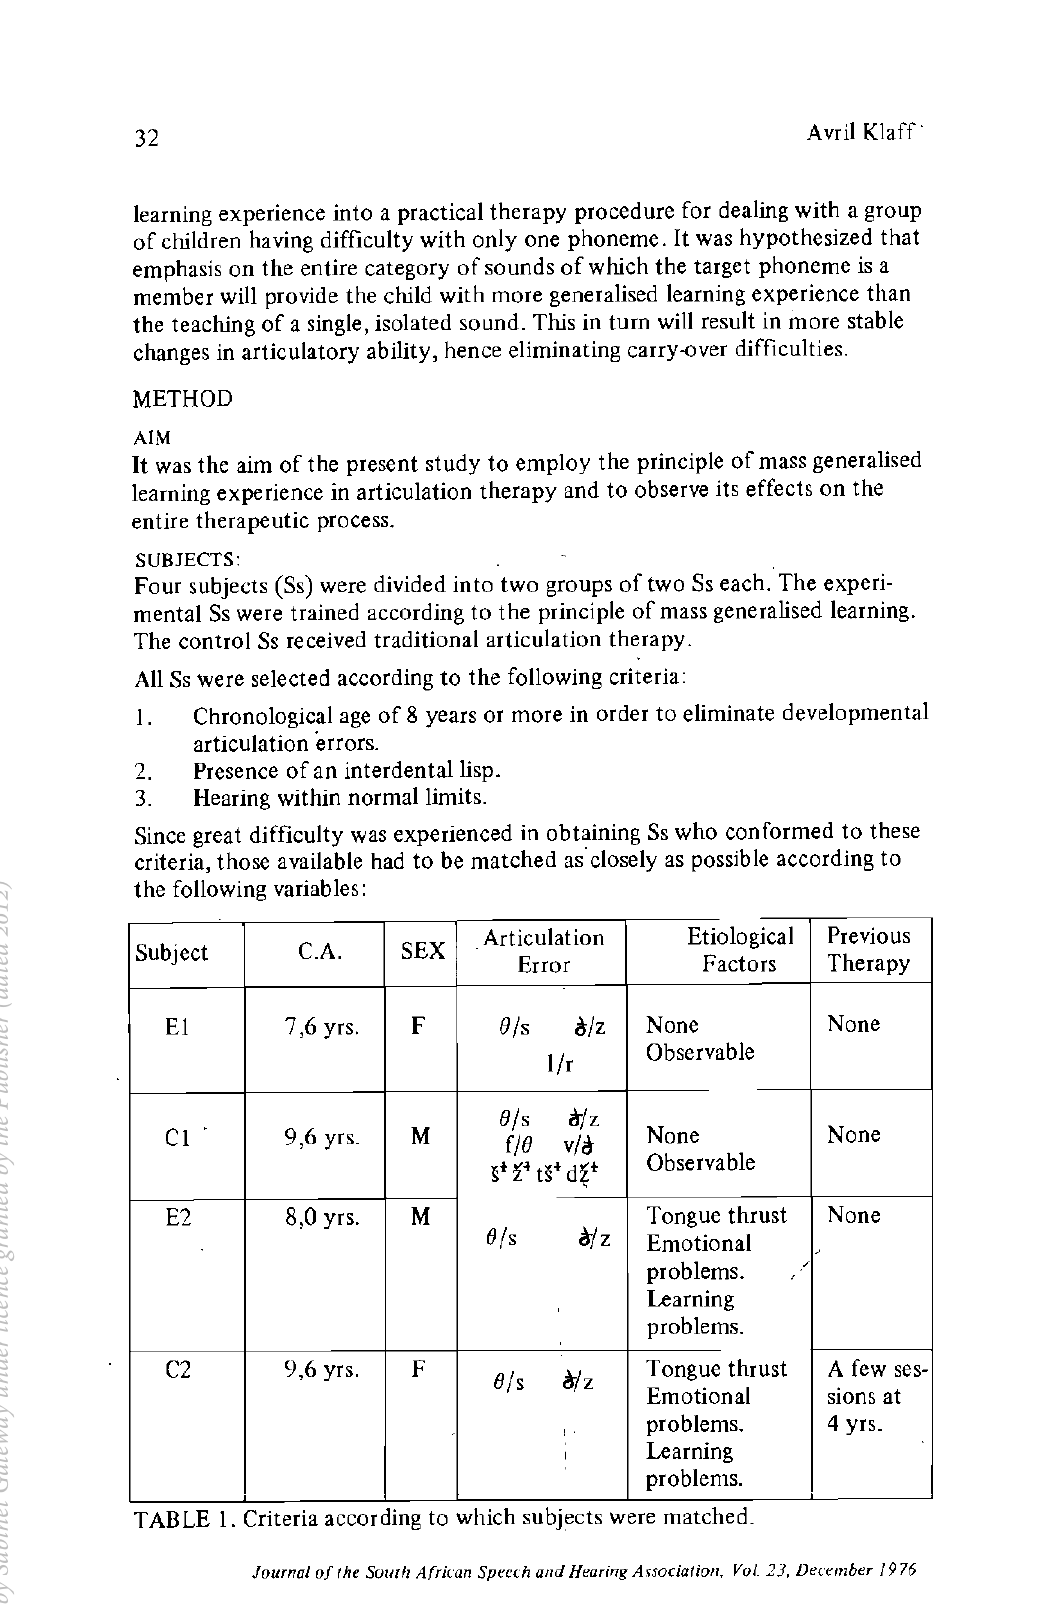
TABLE 1. Criteria according to which subjects were